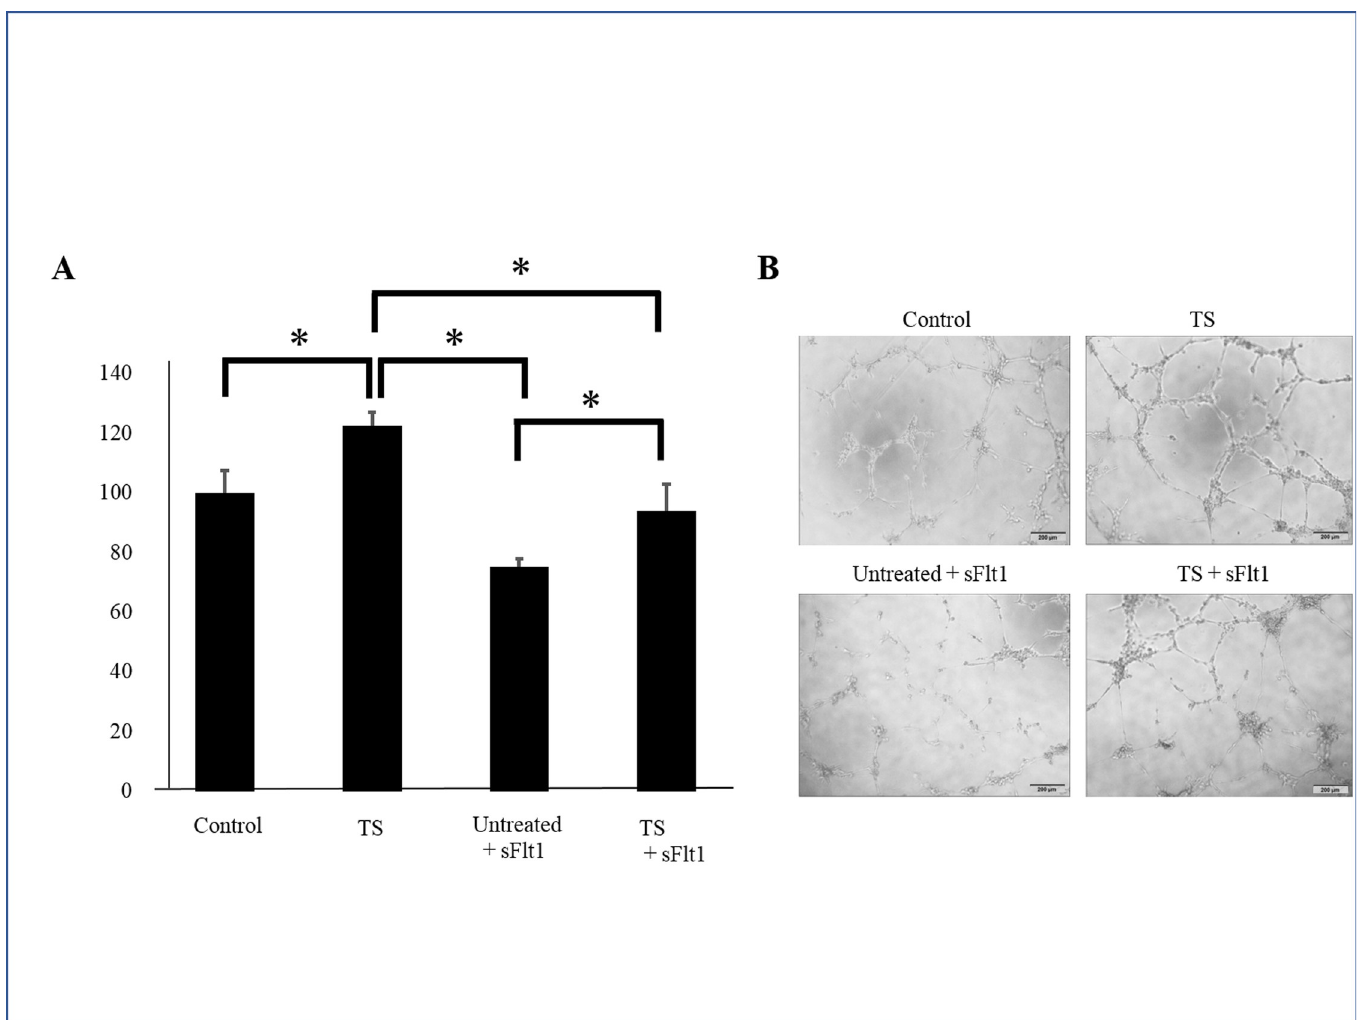
Fig 5. Effect of TS on tube formation of HUVECs with antiangiogenic factors. A: Quantification of total tube length. B: Representative images. � indicates P < 0.05. TS, Tokishakuyakusan; HUVECs, human umbilical vein endothelial cells; sFlt1, soluble fms-like tyrosine kinase 1.